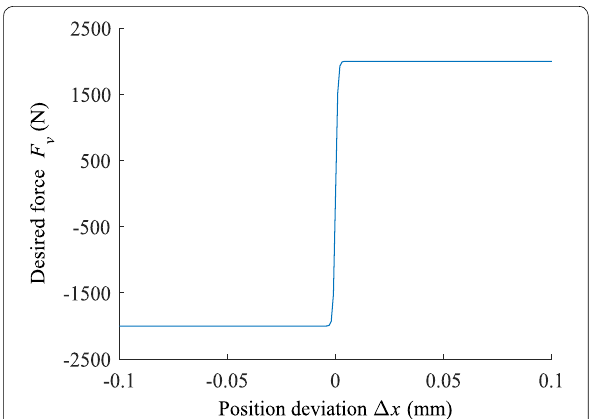
Figure 6 Relationship between the driving force and position